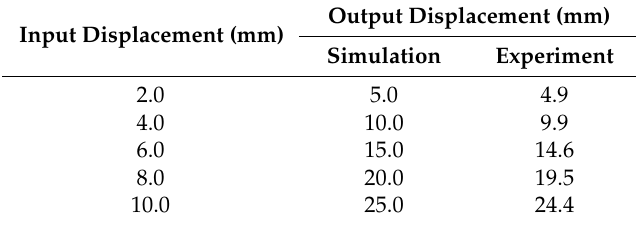
Table 2. Comparison of output displacement from simulation and experiment.